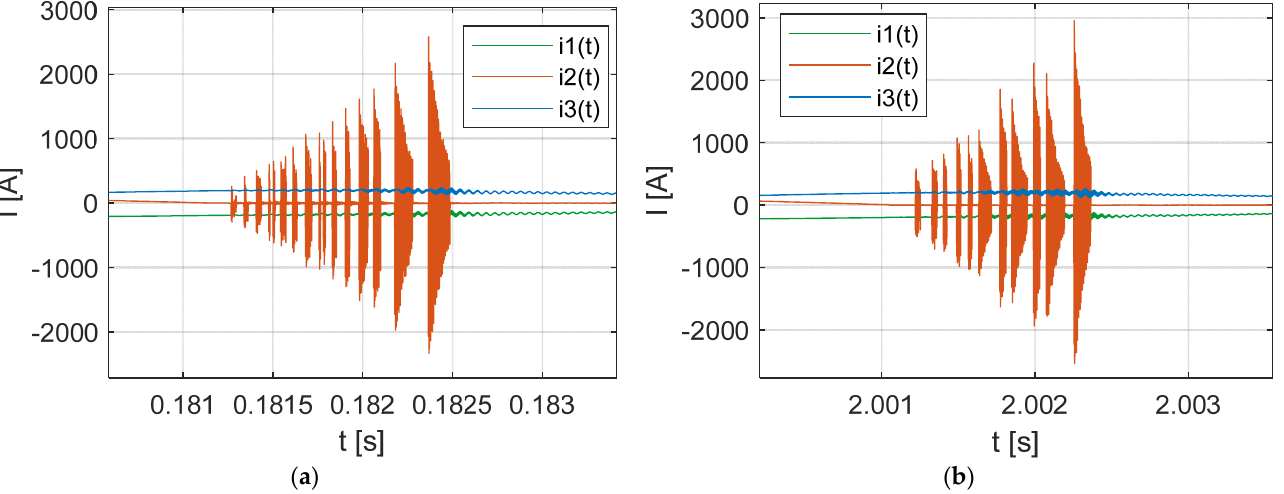
Figure 19. High frequency current ( a ) EMTP algorithm; ( b ) Clark transformation. Source: own calculations. The worst case occurs when the quenching capability of the vacuum circuit breaker